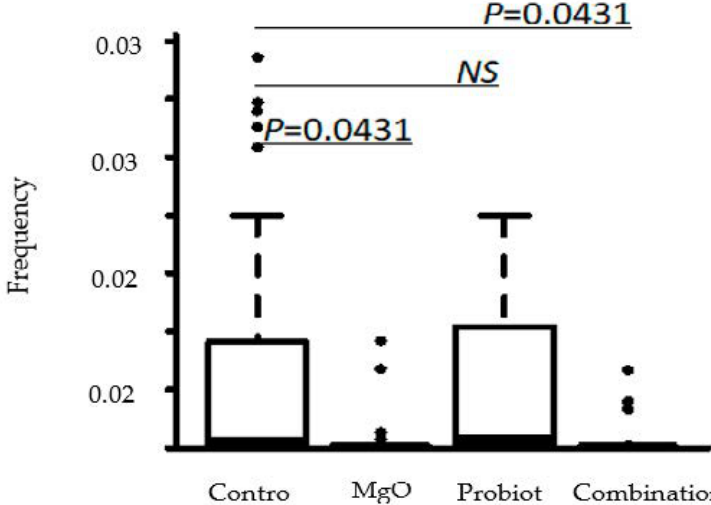
Figure 4. Treatment with magnesium oxide significantly suppressed the presence of the genus Dialister .